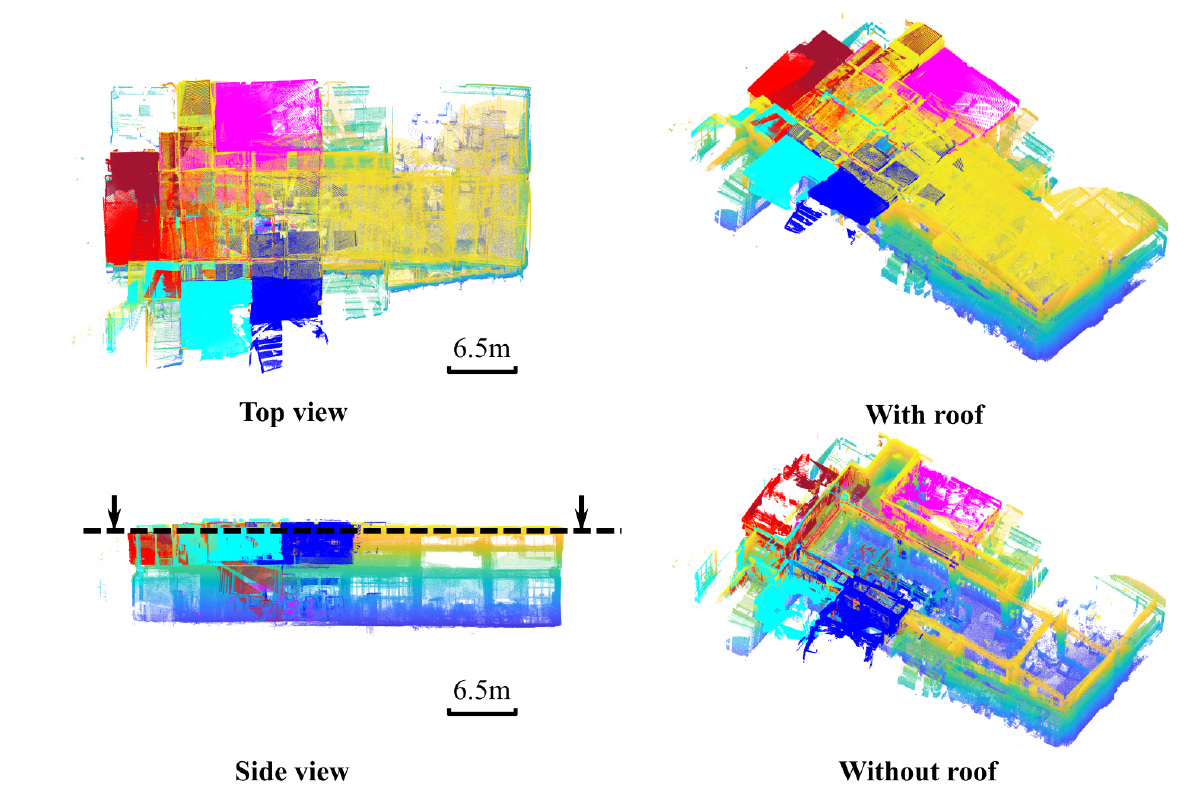
Figure 14. The registration result of scenario 2, which is a complex lab environment. The registered five scenes locate around a U-shape corridor and are colored in magenta, claret red, red, cyan and blue, respectively. By removing the roof part, the complex structure of the indoor model is shown in the bottom right of the figure. Even under such challenging conditions, the proposed method can achieve accurate registration between each indoor and outdoor